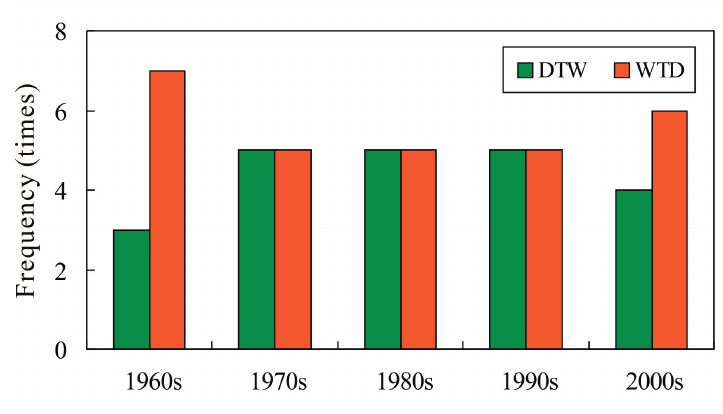
Figure 7. Inter-decadal variation of DWAT events in Poyang Lake basin.